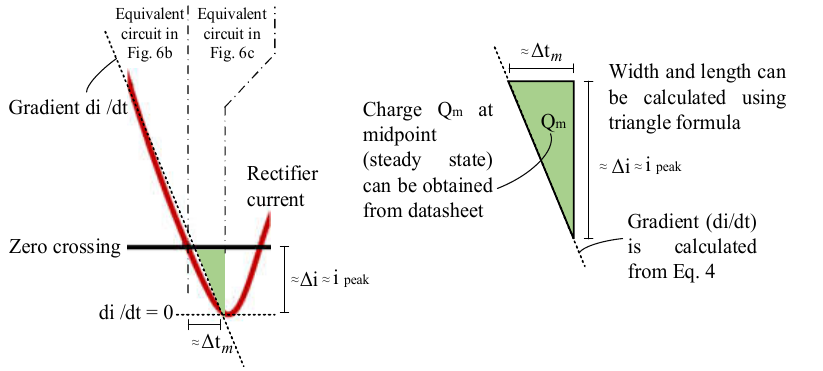
Figure A4. The estimation of negative peak current.